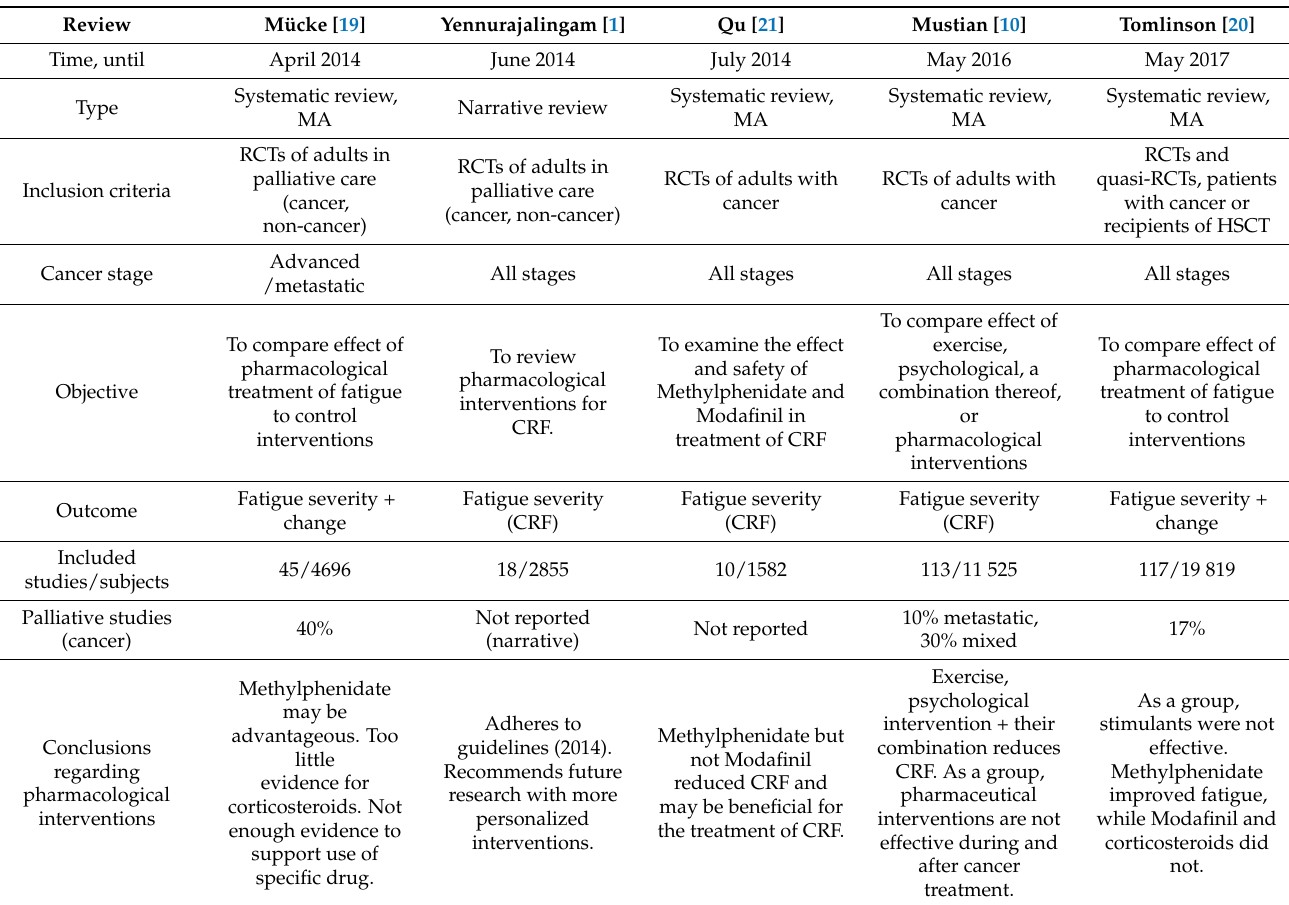
Table 1. Reviews on cancer related